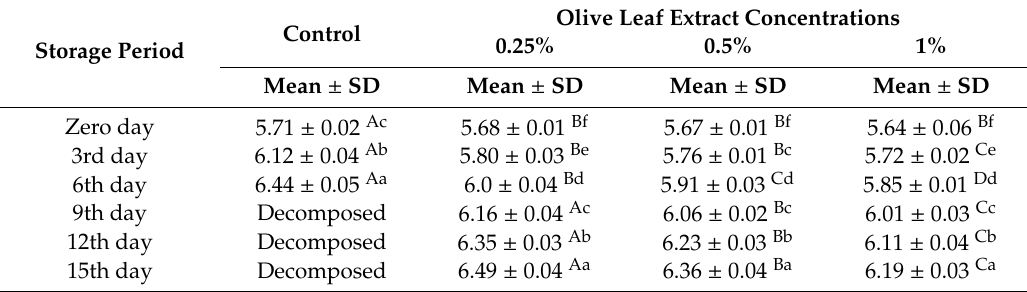
Table 2. Pattern of the pH values of the poultry meat treated with di ff erent concentrations of olive leaf extract during the chilling storage period at 4 ± 1 ◦ C (mean ± standard deviation “SD”).